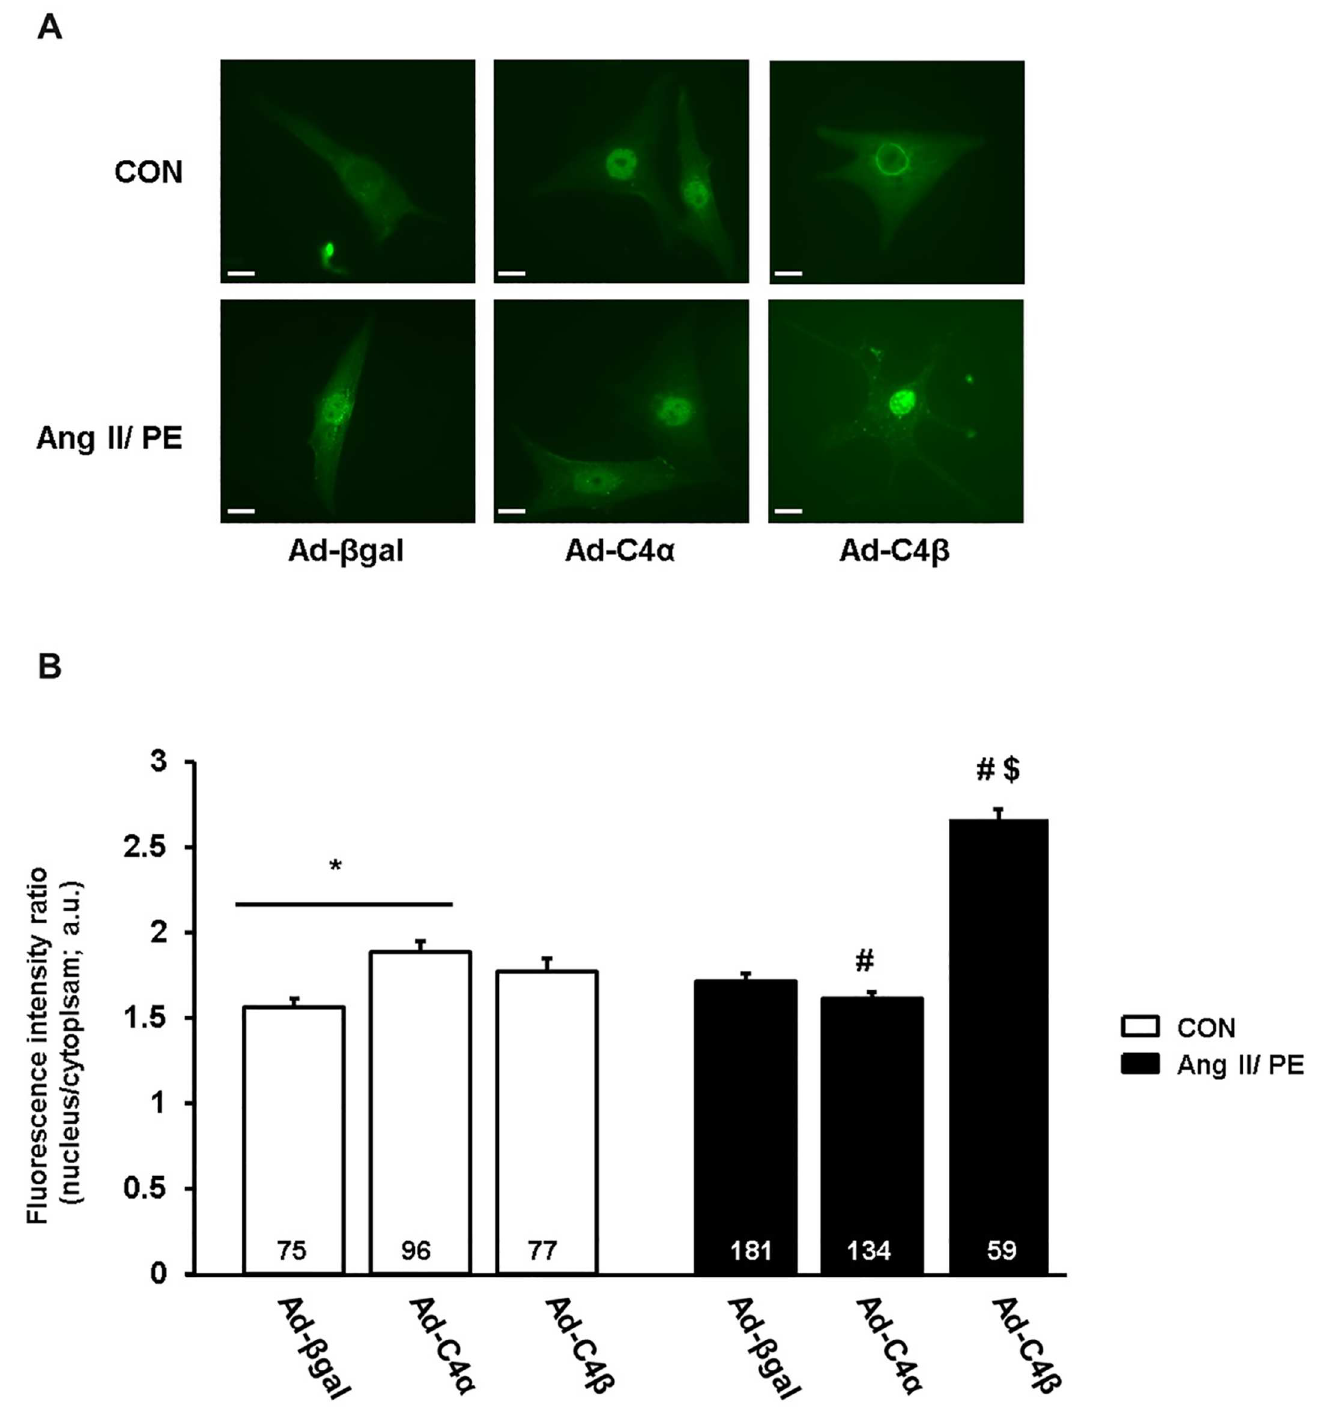
Fig 5. NFATc1 nuclear translocation is promoted by TRPC4 α at baseline and by TRPC4 β upon agonist stimulation. A, Neonatalrat cardiomyocytes (NRCs) were co-infectedwith Ad- β gal,Ad-TRPC4 α or Ad-TRPC4 β / NFATc1-GFP. Nuclearlocalization of NFATc1-GFP was used as an indicatorfor its activation. Green: NFATc1-GFP. Scale bar: 20 μ m. B, Quantification of NFATc1 localizedin the nucleusof NRCs that were stimulatedwith angiotensinII/phenylephrine (Ang II/PE; 1 μ M/50 μ M) or vehicle(CON). * P < 0.05vs unstimulated; # P < 0.05vs Ad-TRPC4 α or Ad- TRPC4 β CON, respectively; $ P < 0.05vs Ad- β galand Ad-TRPC4 α Ang II/PE. Cells from at least three different experiments were analyzed.N-number of cells is indicatedin the bars.